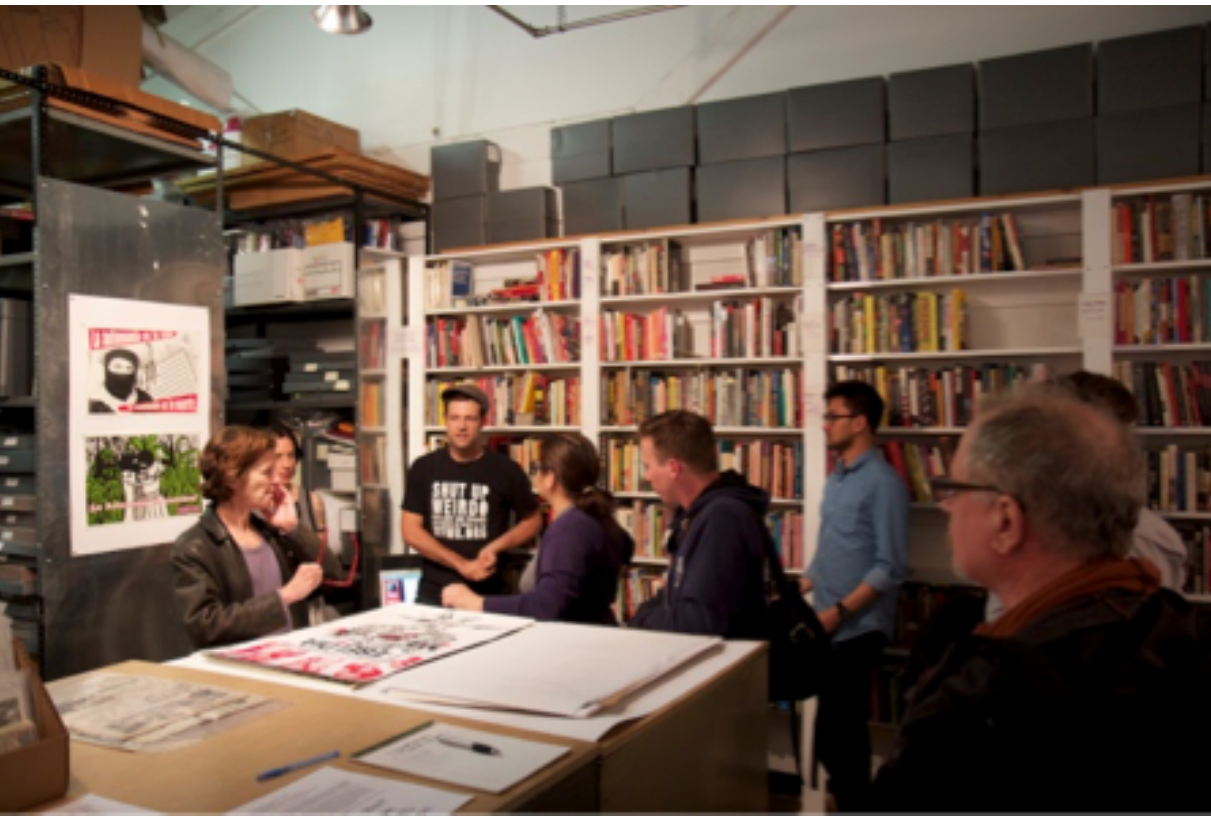
THE FRONT PORTION OF THE ARCHIVE, SHOWING BOOKSHELVES, AS WELL AS FLAT FILES FOR POSTERS. (PHOTO: JEN